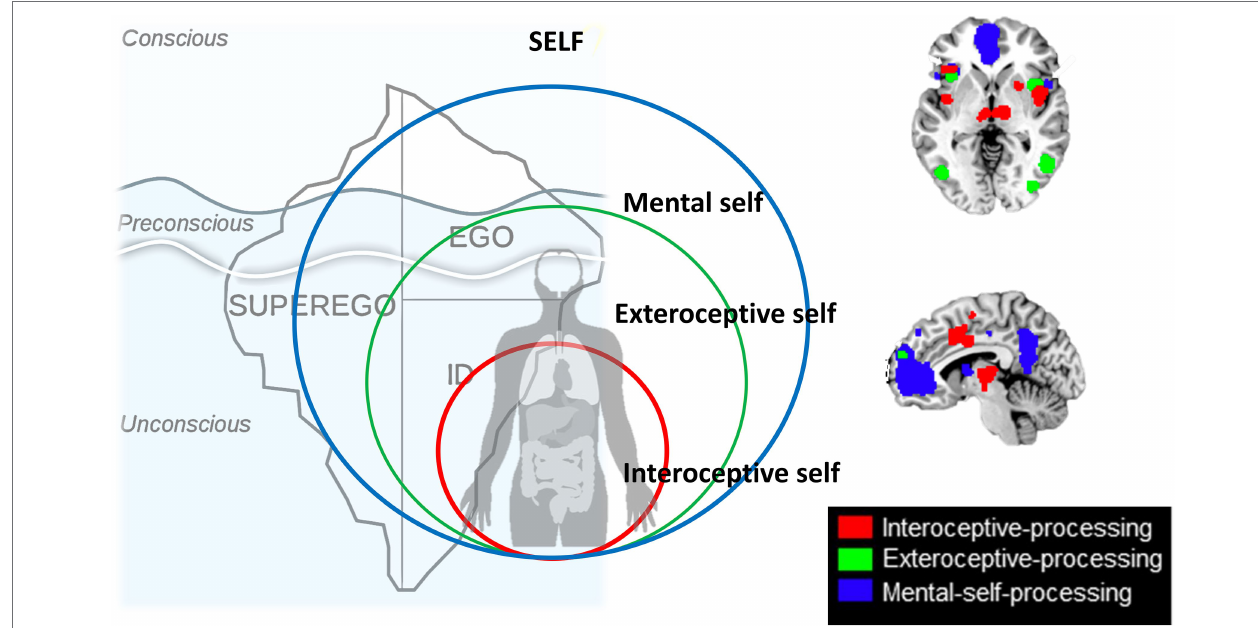
FIGURE 5 | The model of self that embeds and contains the topographical model of Id-Ego-Superego conceptualized by